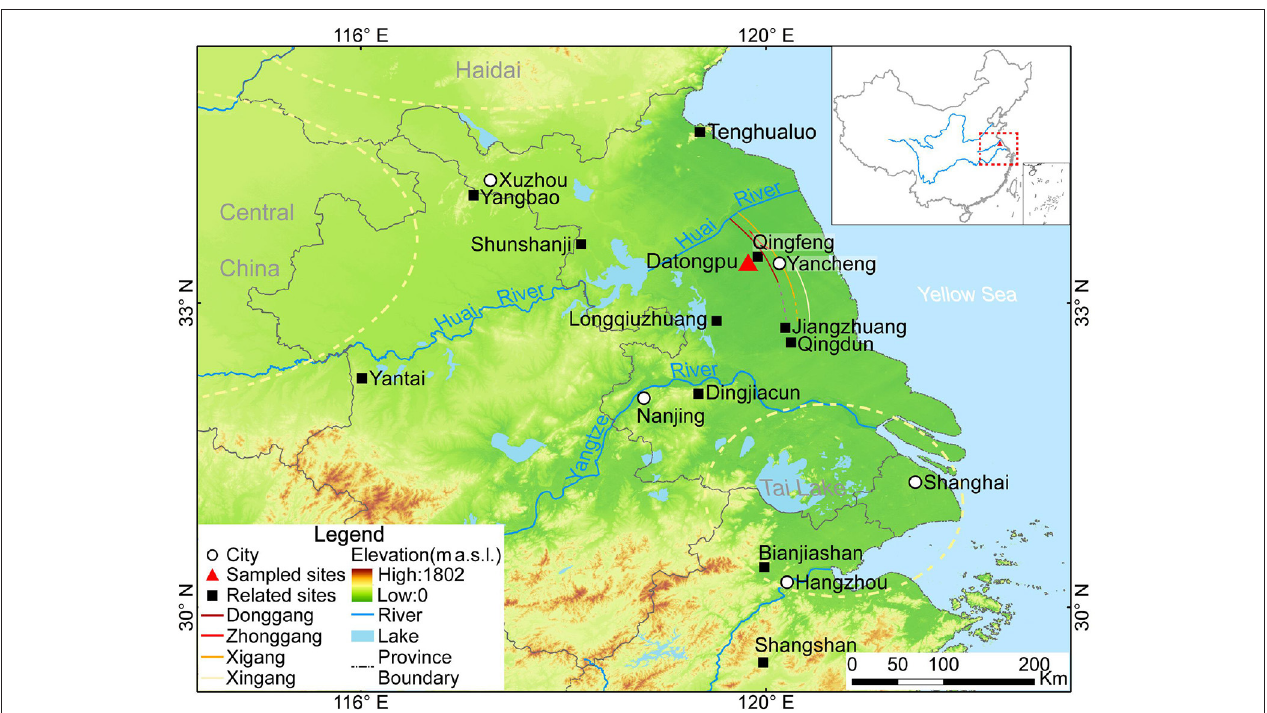
FIGURE 1 | Location of the Datongpu site and related sites in Jiangsu Province and surrounding area (The location of Donggang, Zhonggang, Xigang and Xingang as referred to Zhu et al., 1996).